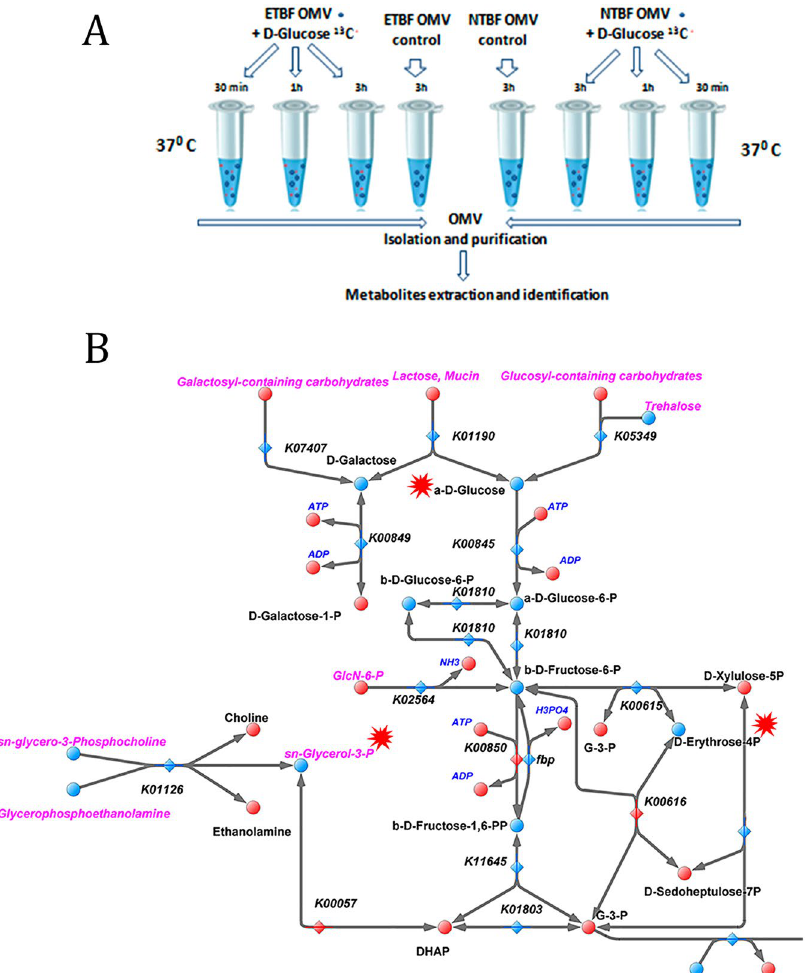
Figure 9. Fluxome experiment. ( A ) The main stages of the fluxome experiment include OMV incubation with isotope-labeled glucose with the following OMV isolation and purification. Extracted metabolites are utilized for metabolome analysis. ( B ) The reconstructed map of the ETBF OMV metabolic pathway (glycolysis). Labeled glucose metabolites such as 13 C 4 -D-erythrose-4P and 13 C 3 -Glycerol-3P were detected only in ETBF OMVs. 13 C 13 C 13 C 13 C 6 -D-Glucose and the products of 6 -D-Glucose catabolism, 4 -D-erythrose-4P and 3 -Glycerol-3P are indicated by red